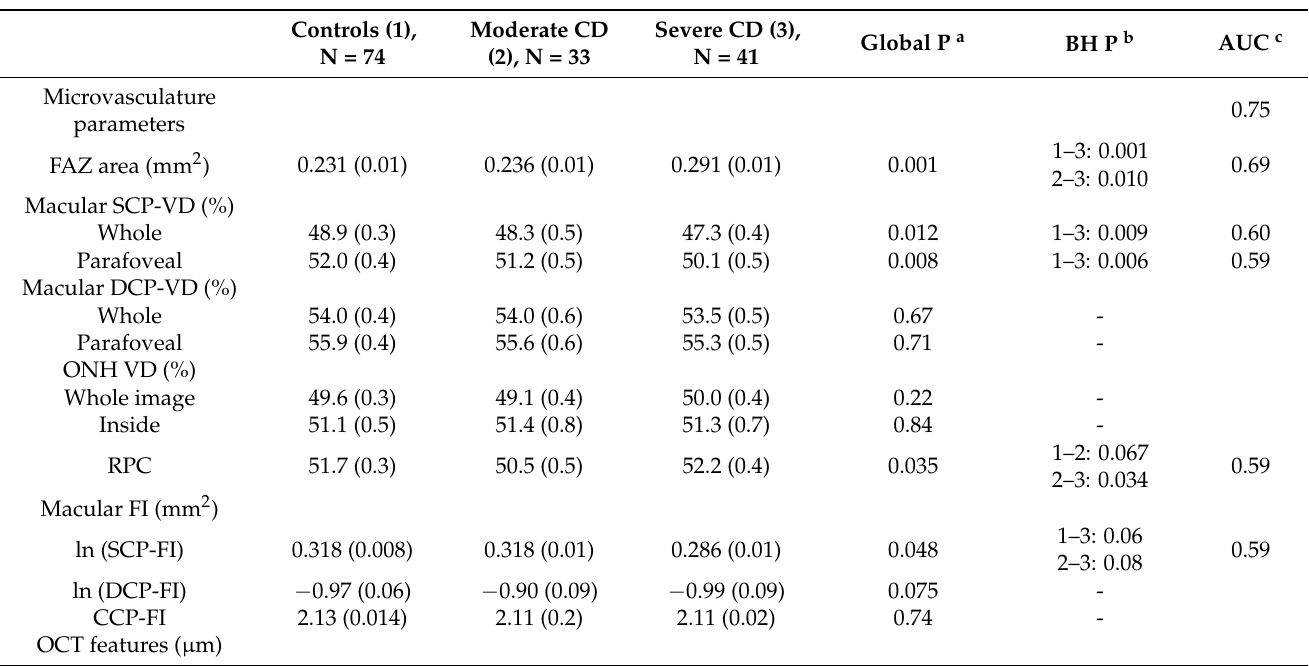
Table 3. Age- and sex-adjusted analysis of covariance, association of retinal variables with Crohn’s disease